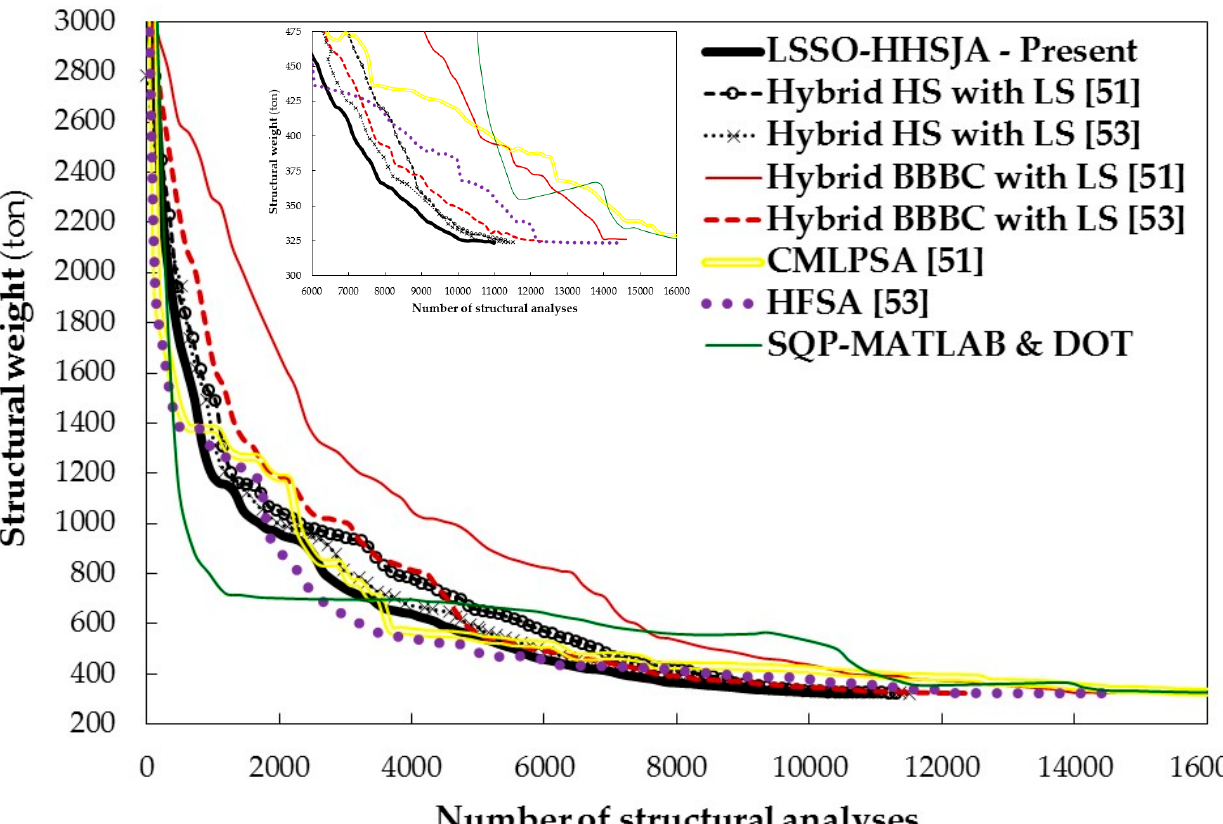
Figure 8. Convergence curves obtained for the 3586-bar tower design example.